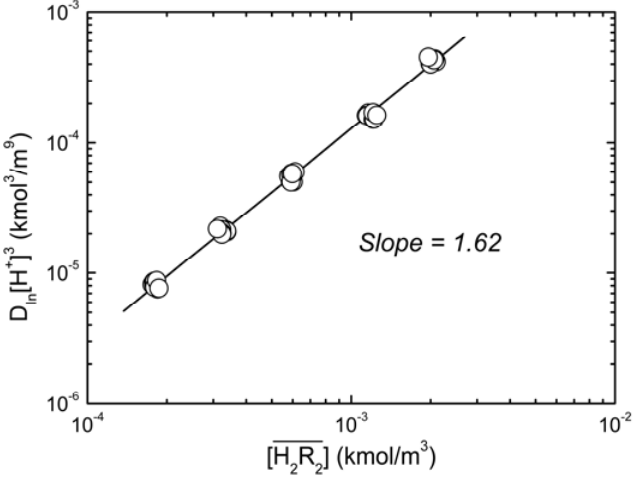
Figure 3. Log-plots of D concentrations in kerosene at 25  C.